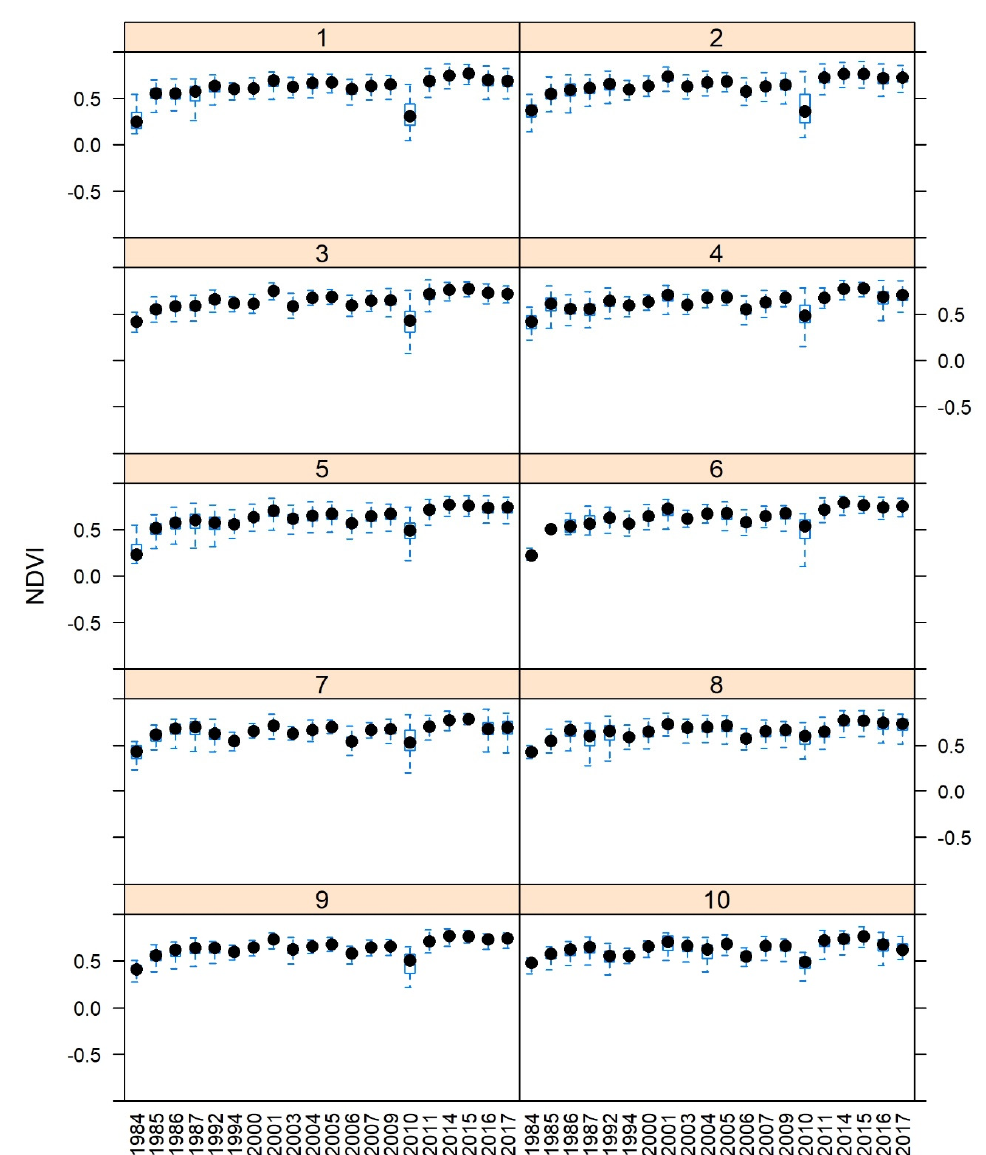
Figure 7. NDVI values of vegetated areas (MNDWI < 0) in the 10 basins of Lake Tisza between 1984 and